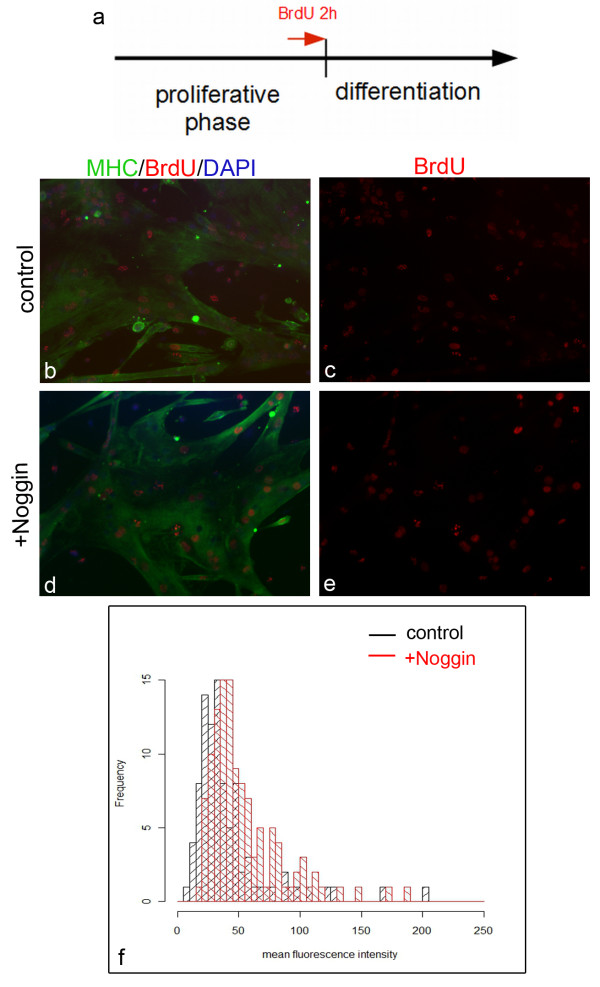
Inhibition of BMP signaling triggers immediate cell cycle exit of satellite cells. (A) Prior to the induction of differentiation, cultures of proliferating satellite cells were supplemented for 2 hours with BrdU and cultured for 3 days in differentiation medium. Myonuclei within MHC-positive myotubes from control cultures (B-C) show weak BrdU signals, while Noggin-treated myonuclei (D-E) show BrdU signals of stronger intensity in MHC-positive myotubes. (F) Analysis of the mean fluorescence intensity of the BrdU signal of Noggin-treated cultures (red columns; n = 92 myonuclei) compared to control cultures (black columns; n = 117 myonuclei). Histogram showing a shift in the frequency of Noggin-treated cells to higher levels of BrdU (p < 0,005; Wilcoxon test).